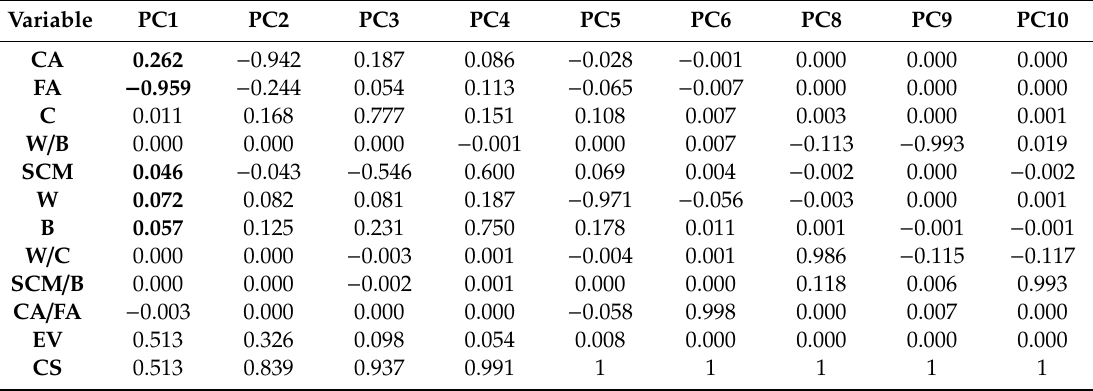
Table 1. Principal component analysis results to select optimal input combination.